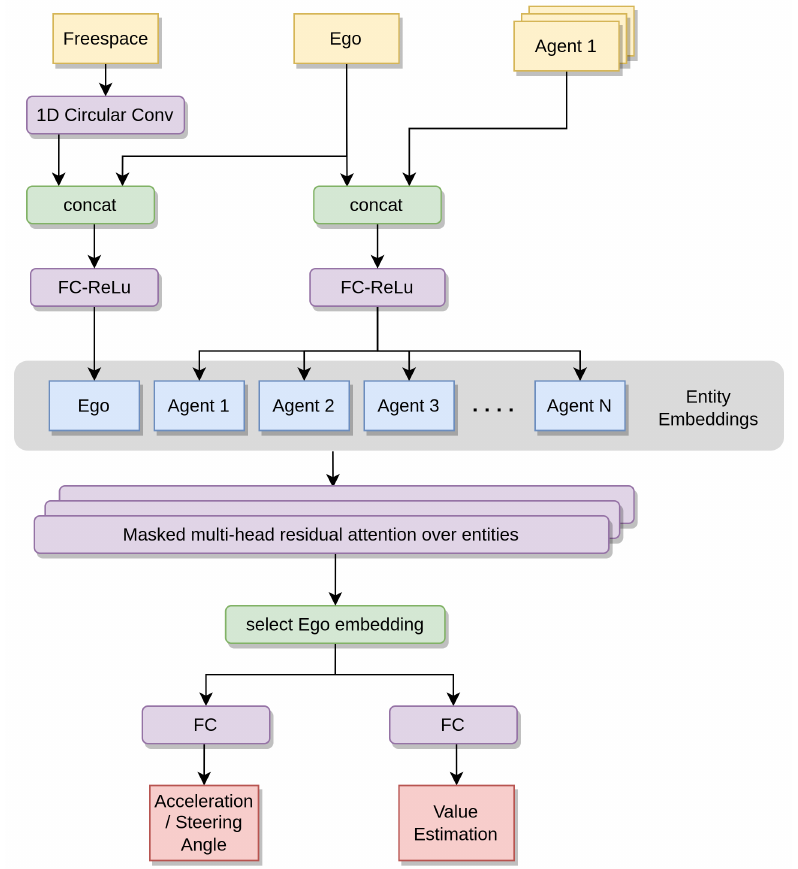
Figure 7. The architecture of the neural network. Inputs to the network are color-coded as yellow. Learnable parameters are presented as purple blocks, while math operations are green. Outputs are